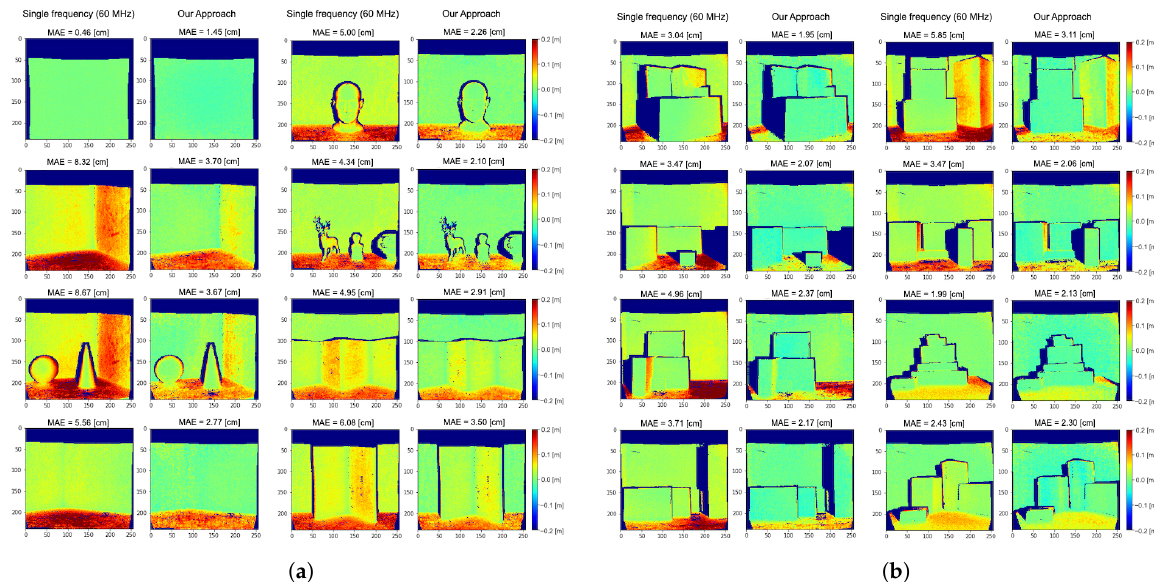
Figure 5. Depth error maps on the real datasets S 4 ( a ) and S 5 ( b ) obtained applying our method and a single frequency prediction at 60 MHz. Blue colour indicates depth underestimation, while red colour indicates depth overestimation. The dark blue areas are those for which we do not have ground truth depth available. The Mean Absolute Error (MAE) for each scene is also reported.